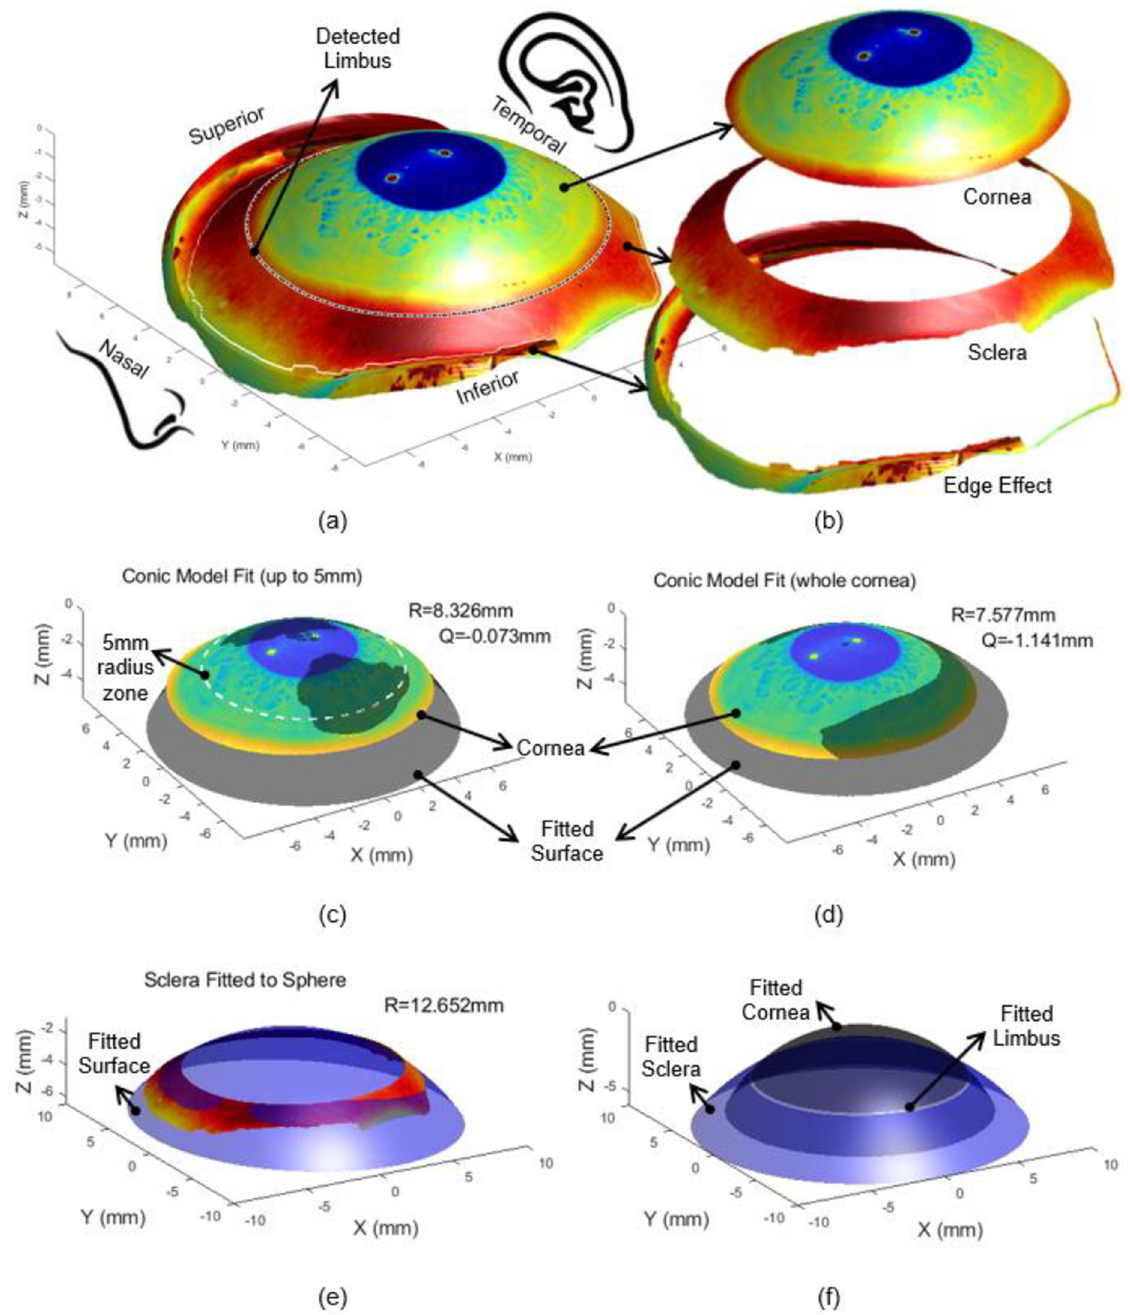
Fig 2. Left eye of a 25 year old male subject where the eye’s front image was projected on the surface for displaying purpose (a) as scanned by the ESP, where the limbus was detected in three-dimensions [8] (b) after being processed to split cornea, sclera and the edge effect artefacts following Abass’s method. Two edge detection strategies were used simultaneously to cut the edge of the eye’s surface data at the border between the authentic eye surface and the artificial boundaries which result from interference of tears, eyelid edges or lashes [46] (c) corneal conic fit up to 5mm, (d) whole corneal conic fit, (e) sclera fitted to a sphere, (f) Fitted limbus as constructed by the intersection of the fitted surfaces representing the cornea and the sclera.